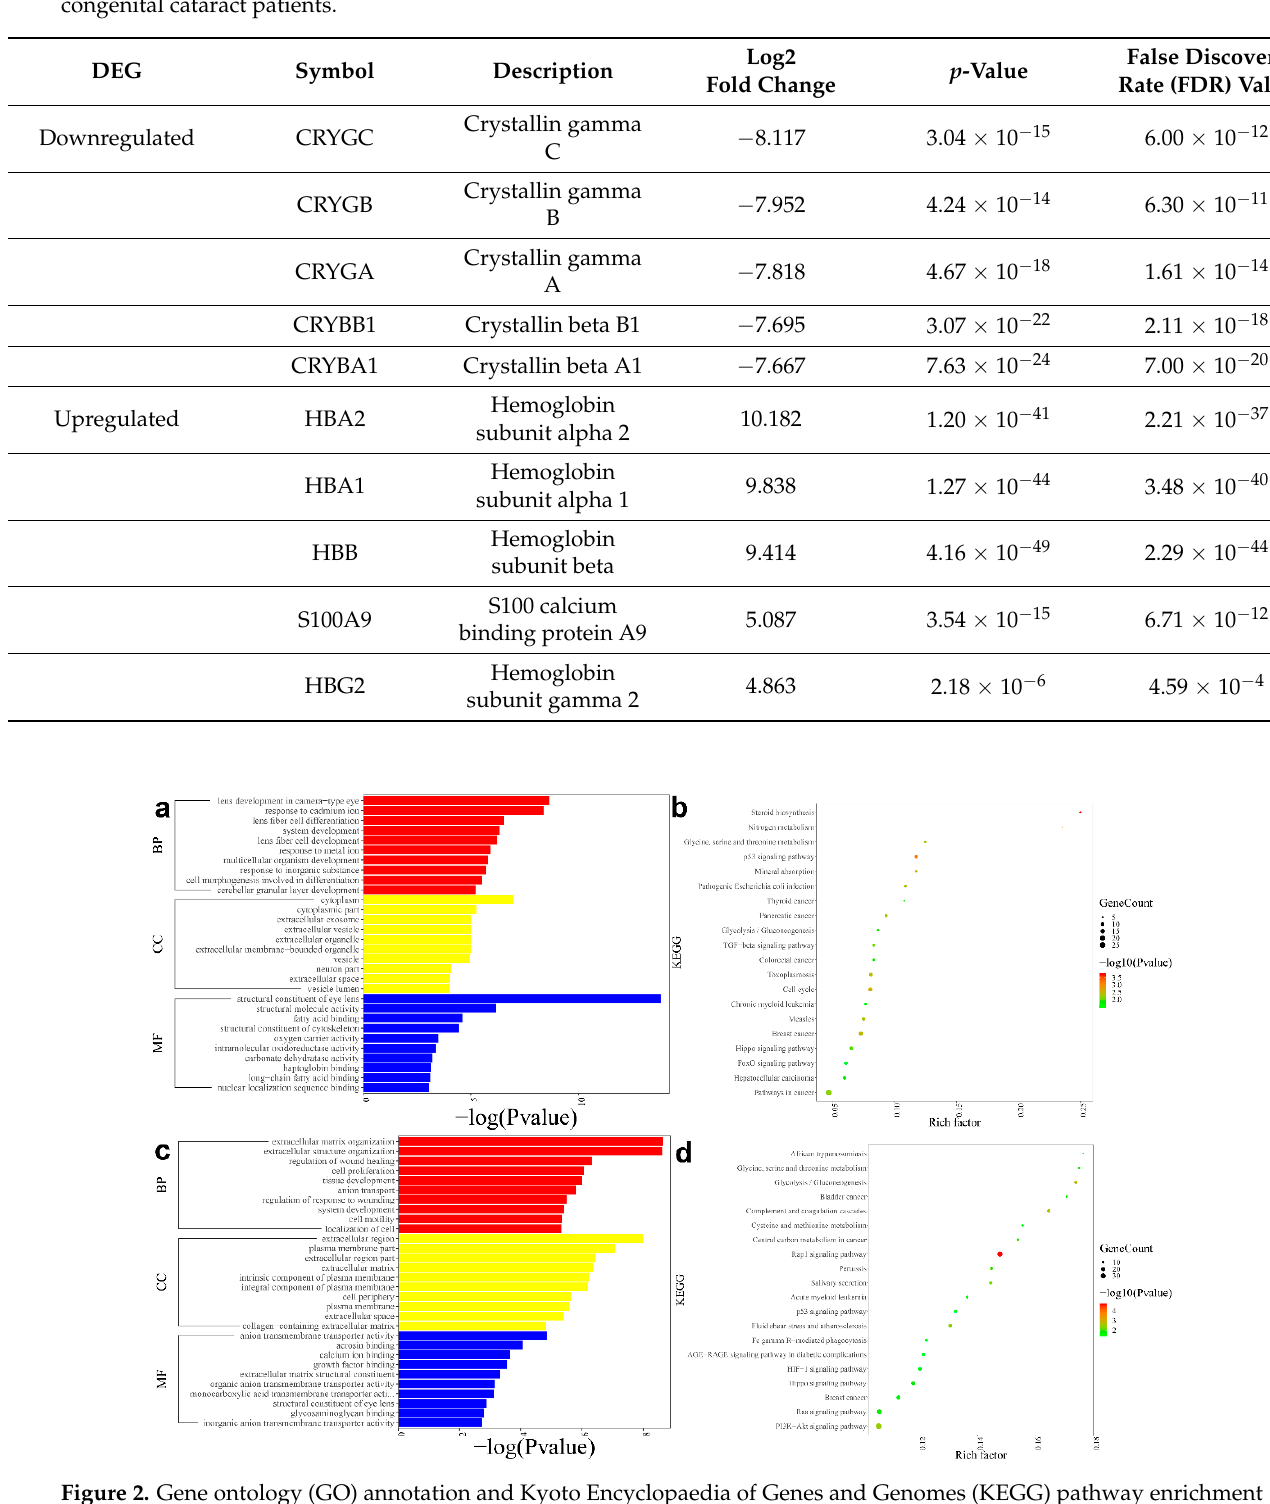
Figure 2. Gene ontology (GO) annotation and Kyoto Encyclopaedia of Genes and Genomes (KEGG) pathway enrichment analysis results for the DEGs of the posterior subcapsular congenital cataract patients compared with those of the normal controls. ( a ) The top 30 GO enrichment of the DEGs in the anterior lens capsule samples; ( b ) the top 20 KEGG enrichment analysis results of the DEGs in the anterior lens capsule samples; ( c ) the top 30 GO enrichment of the DEGs in the cortex and nuclear fibres; ( d ) the top 20 KEGG enrichment analysis results of the DEGs in cortex and nuclear fibres.